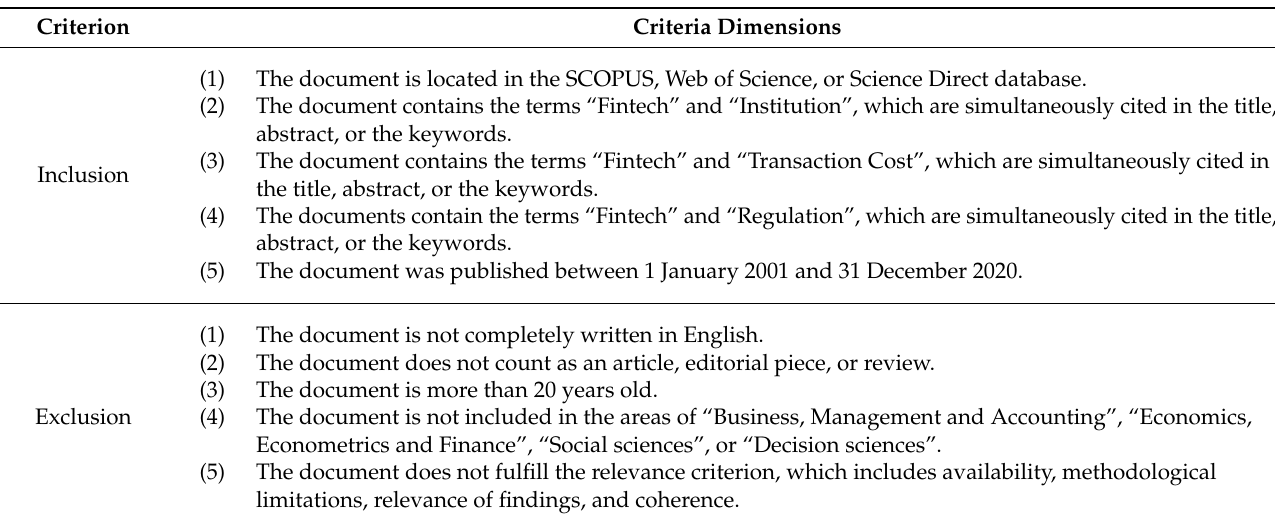
Table 2. Inclusion and exclusion criteria for the documents used in the systematic